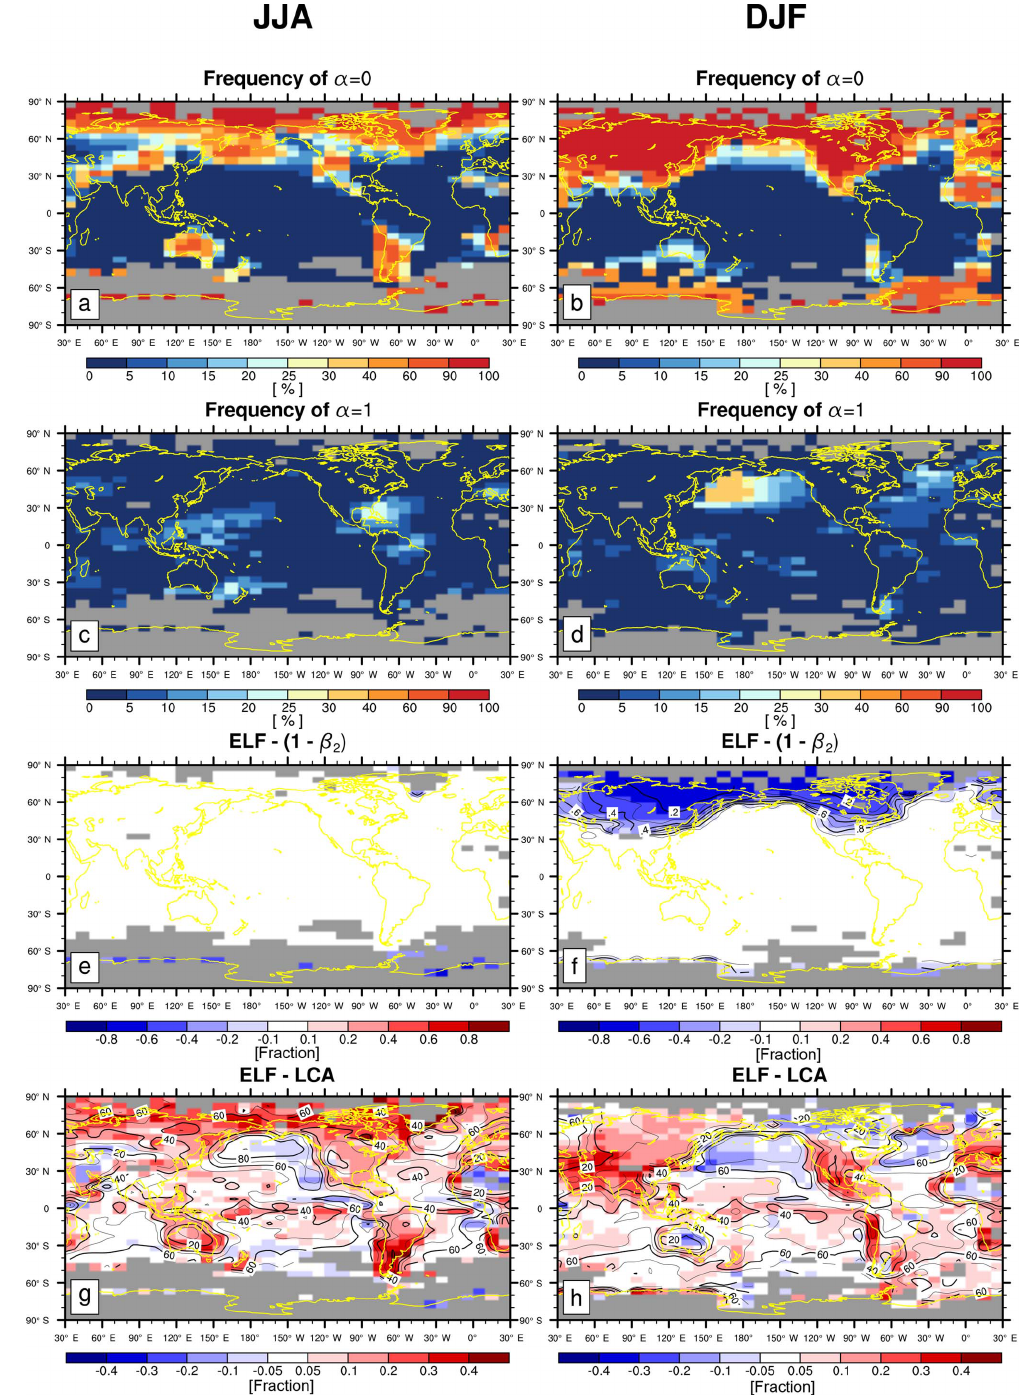
Figure 2. (a, b) Frequency of occurrence of α = 0 (i.e., z inv ≤ z LCL ) among all observations (the sum of 0 < α < 1, α = 0, and α = 1); (c, d) frequency of occurrence of α = 1 (i.e., z inv ≥ (cid:49)z s + z LCL ) among all observations; (e, f) the difference between ELF and 1 − β 2 = ELF /f , where f is the freeze-dry factor (see Eqs. 9, 10); and (g, h) the difference between ELF and LCA during (left column) JJA and (right column) DJF. In panels (e) and (f) , the contour lines denotes the freeze-dry factor, f . In panels (g) and (h) , the contour lines denotes the climatological LCA reported by surface observers. All observations are used for the panels (e)–(h) . The grid boxes with a climatological observation number below 100 in each season are masked by gray